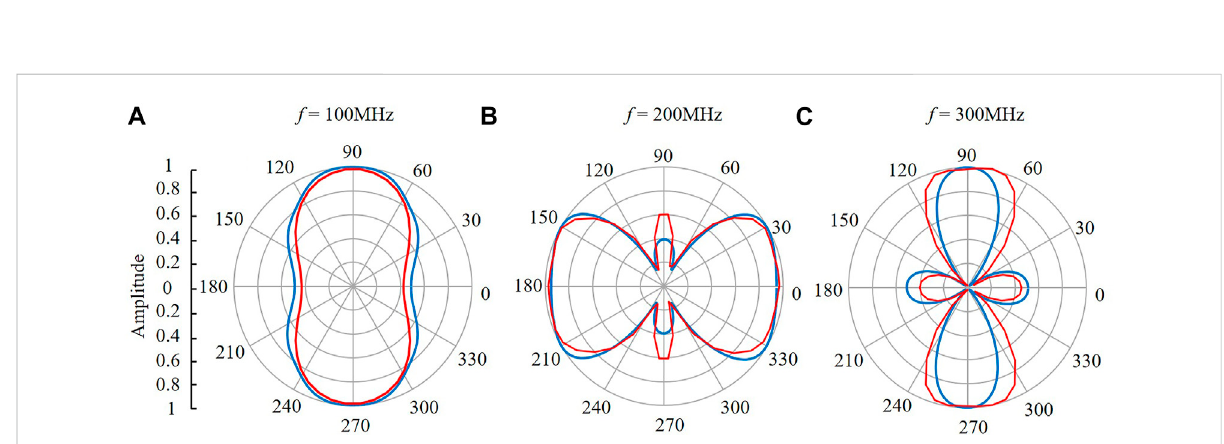
FEM simulation of the photoacoustic amplitude polar distribution patterns at the near- fi eld ξ = 1.2 (blue line) and far- fi eld ξ = 6 ((red line) for various frequencies. (A – C) respectively for the frequency of 100, 200 and 300